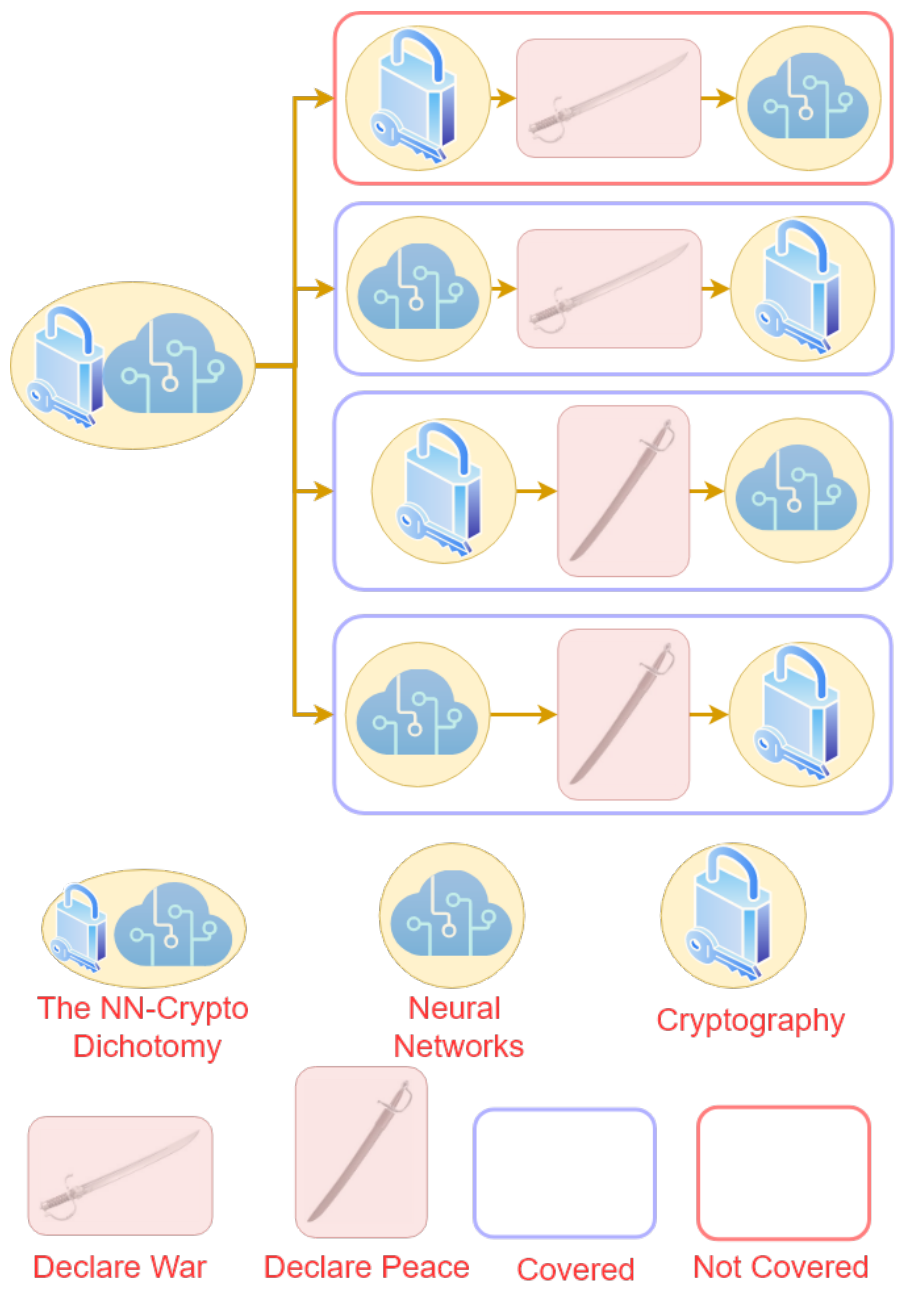
Figure 4. The covered and uncovered aspects in the war-and-peace dichotomy of neural networks and